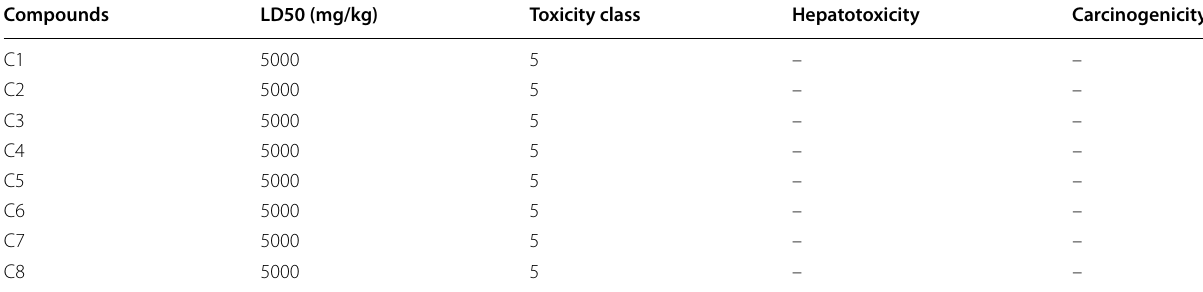
Table 6 ProTox-II toxicity